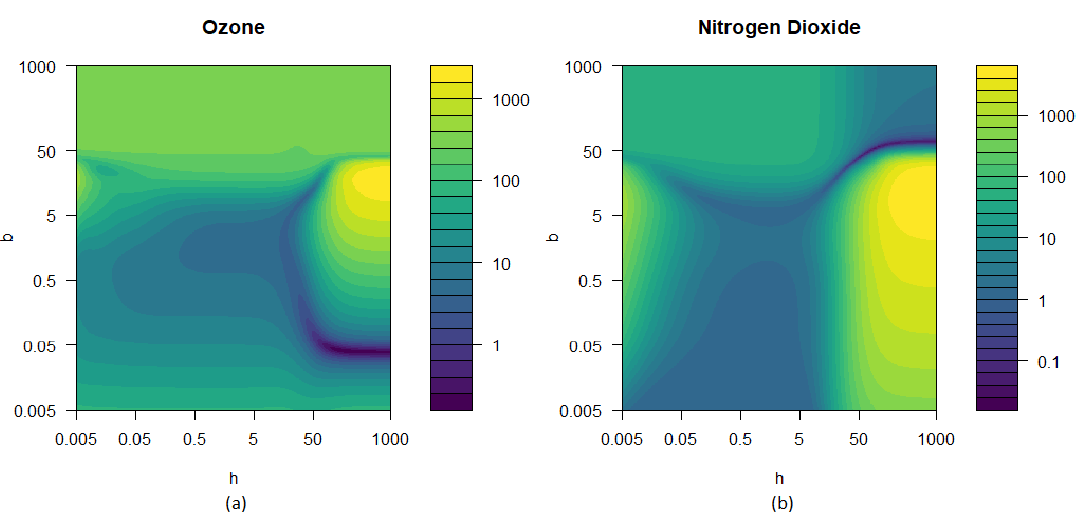
Figure 3. Estimation of the mean squared errors of the proposed estimator as a function of h and b , obtained by the bootstrap. ( a ) mean squared error ( MSE ∗ ) of the estimator for the mean level of ozone. ( b ) MSE ∗ of the estimator for the mean level of nitrogen dioxide.